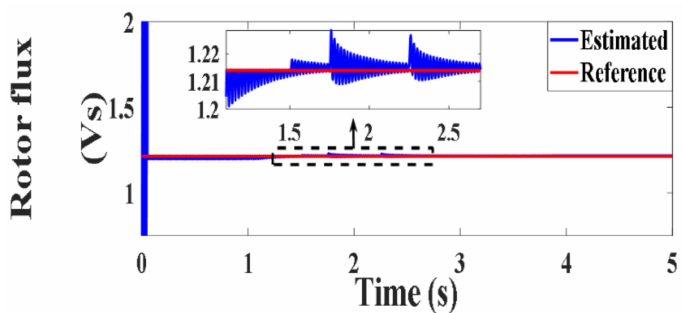
Figure 13. Rotor flux under SVOC (Vs).